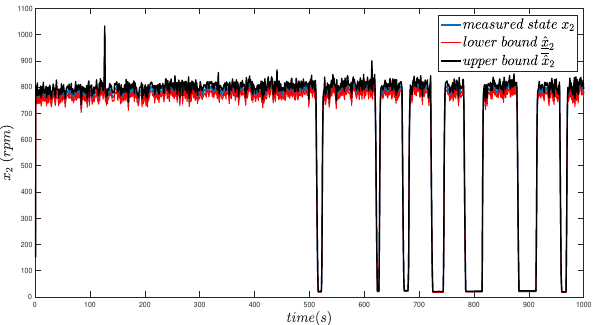
Figure 9. Measurement of rotational speed x 2 ( k ) and estimation of interval bounds.